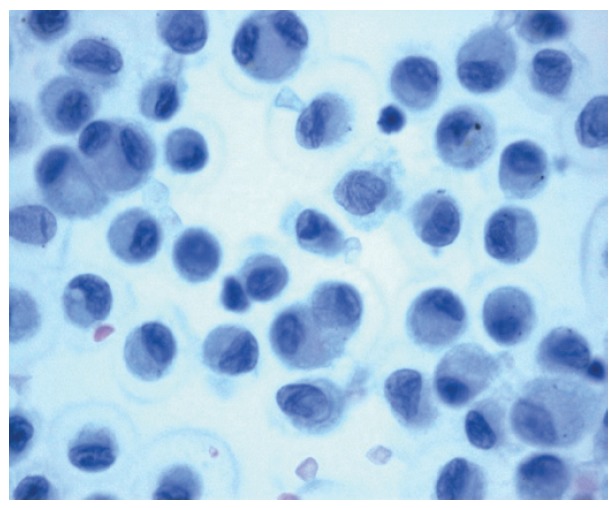
 Fotomicrografia mostrando macrófagos espumosos no LBA
(May-Grümwald-Giemsa; aumento, 400×).